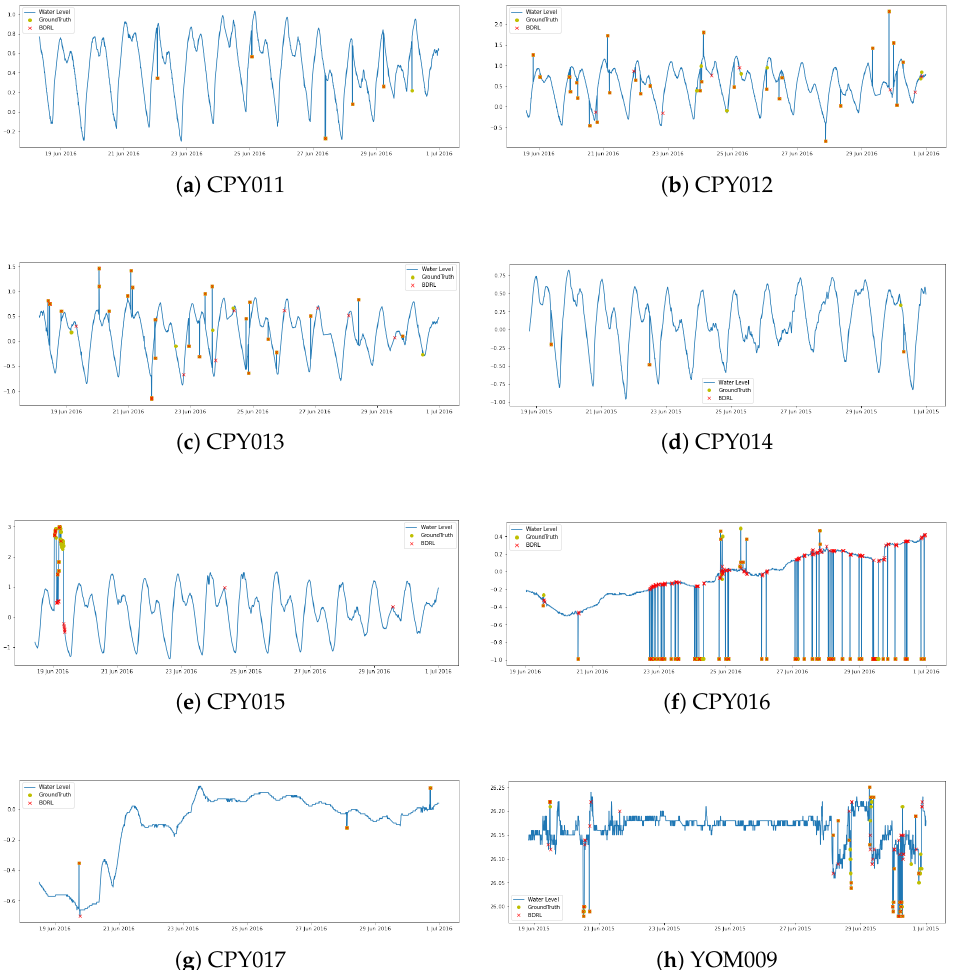
Figure 5. Anomaly detection from the best DRL model of each station. ( a ) CPY011 with DRL ; ( b ) CPY012 with DRL Valid ; ( c ) CPY013 with DRL F 1 ; ( d ) CPY014 with DRL Rwd ; ( e ) CPY015 with DRL F 1 ; ( f ) CPY016 with DRL F 1 ; ( g ) CPY017 with DRL ; ( h ) YOM009 with DRL Acc